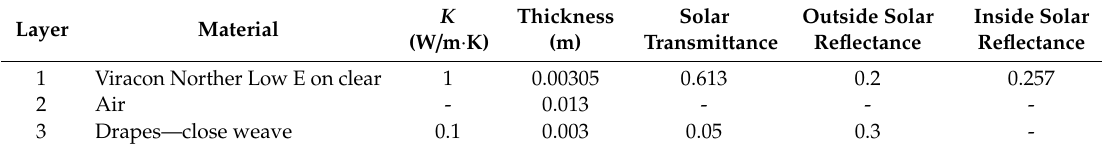
Table 4. Properties of openings.